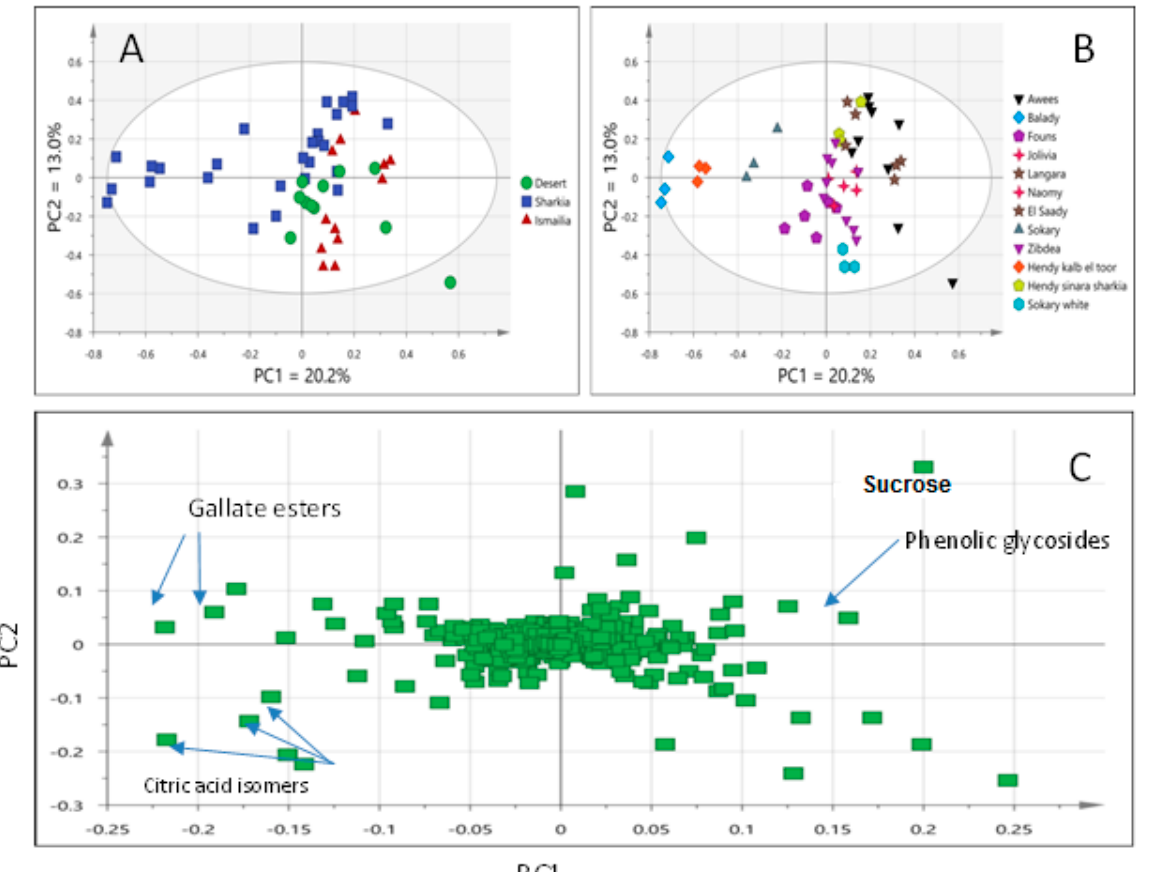
Figure 3. Score plot of PCA model of all mango samples UPLC/MS data classified based on geo- graphical origin ( A ), cultivar ( B ), and corresponding loading plot ( C ).